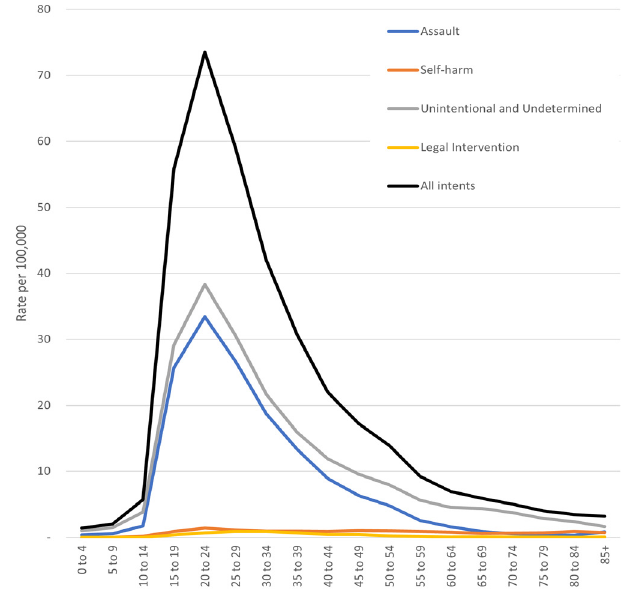
Figure 3. Rate of nonfatal firearm injury episodes in the United States per 100,000 population, by 5-year age group and Injury Intent,